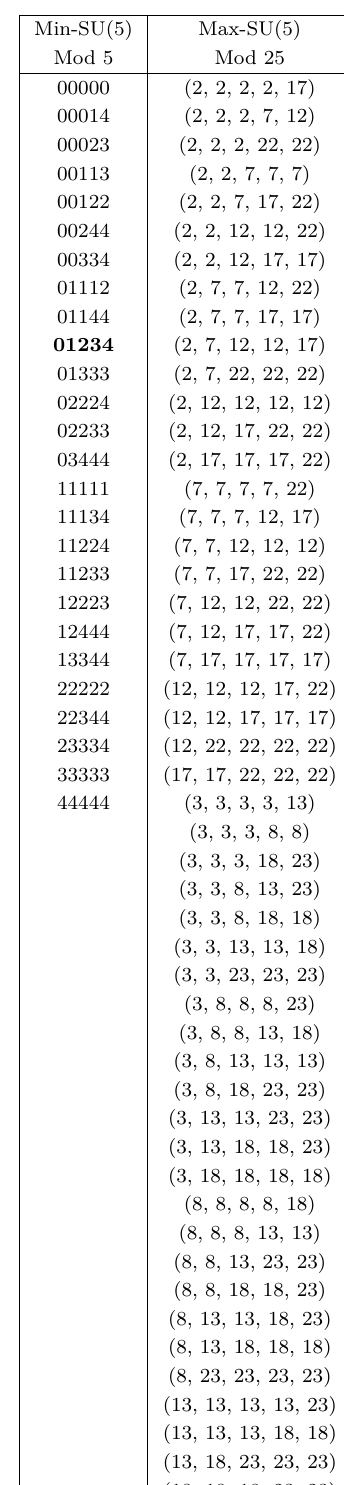
. In the thermal case, there is a unique F